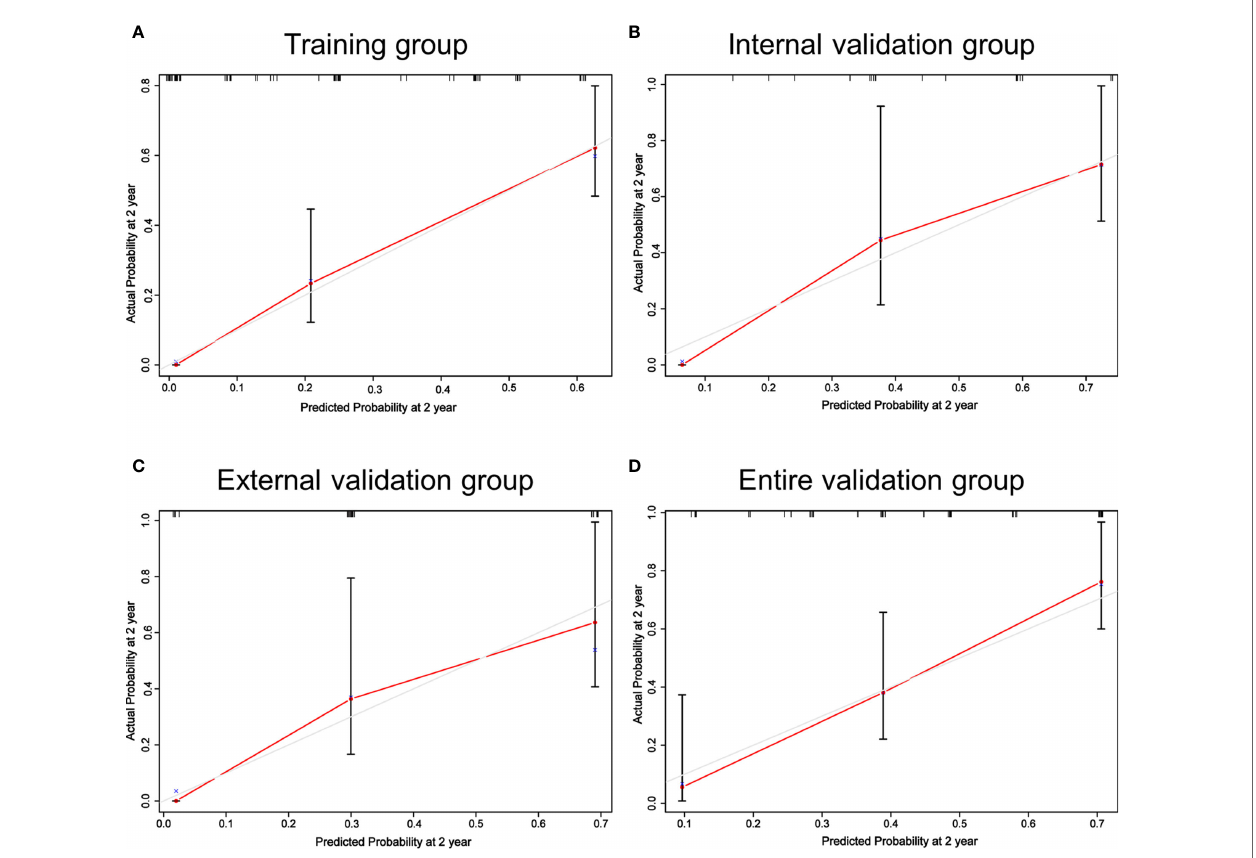
FIGURE 2 | Calibrations of the nomogram for 2-year OS in the training (A) , internal validation (B) , external validation (C) and entire validation groups (D) . The tint line at 45° represent perfect prediction and the red line represent actual prediction of our